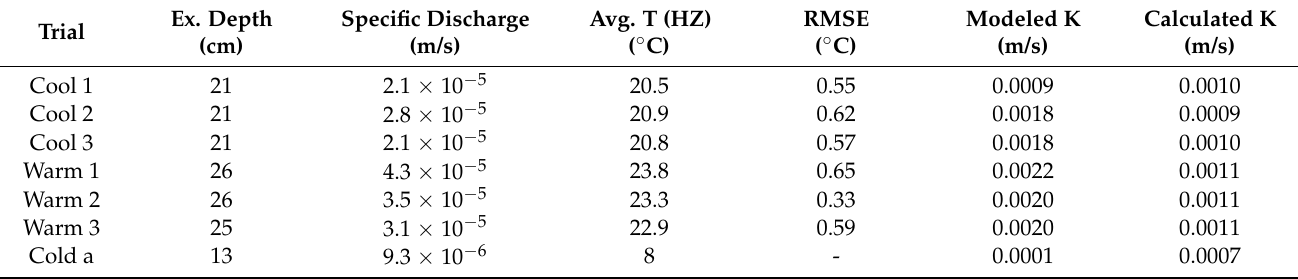
Table 3. Model results of cool runs 1–3, warm runs 1–3, and the theoretical cold run (a). Ex. Trial